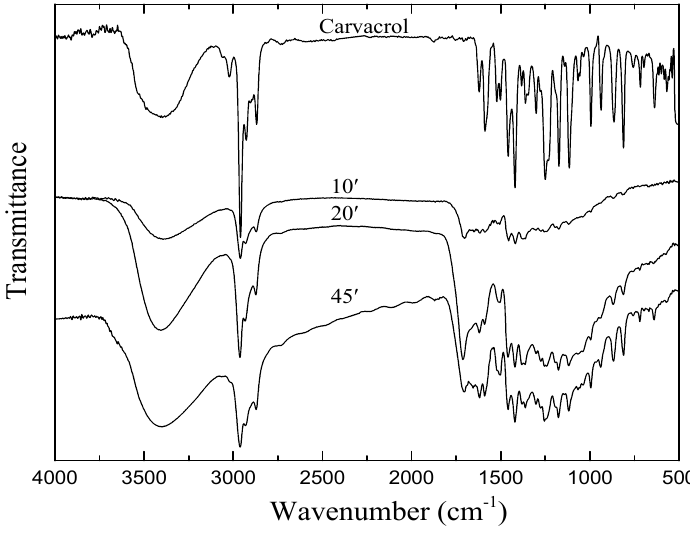
Figure 5. Fourier-transform infrared spectroscopy FTIR absorption spectra of liquid and plasma deposited carvacrol films grown under different deposition times.